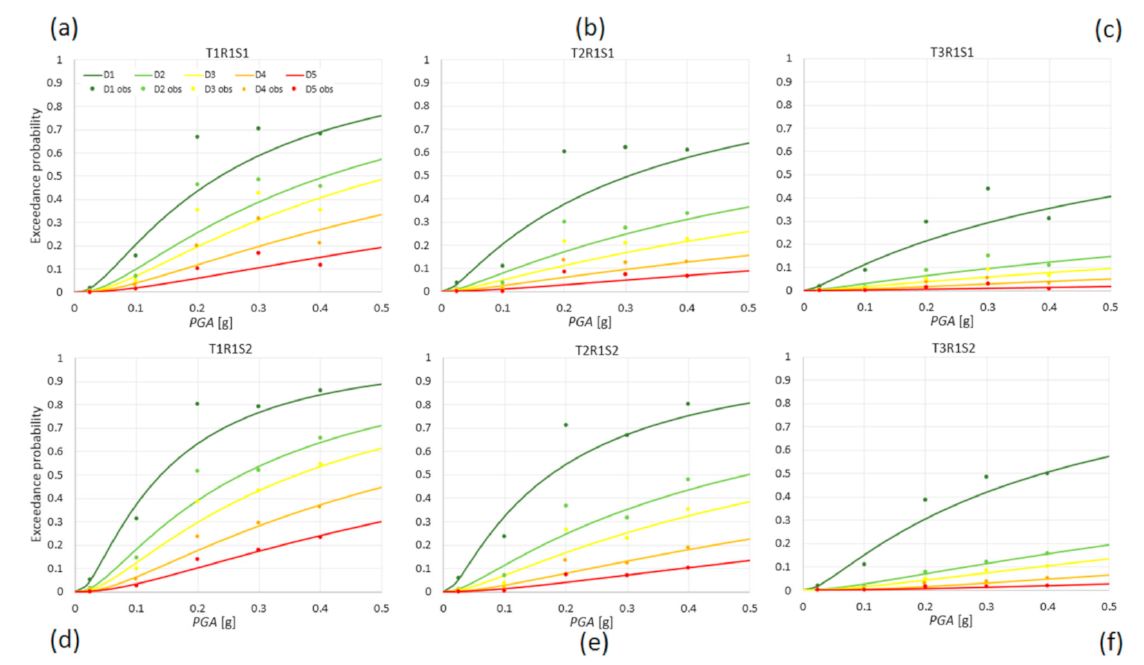
Figure 6. Fragility curves fitting observed damage data for typological classes with state of repair R1: ( a ) T1R1S1, ( b ) T2R1S1, ( c ) T3R1S1, ( d ) T1R1S2, ( e ) T2R1S2, and ( f )